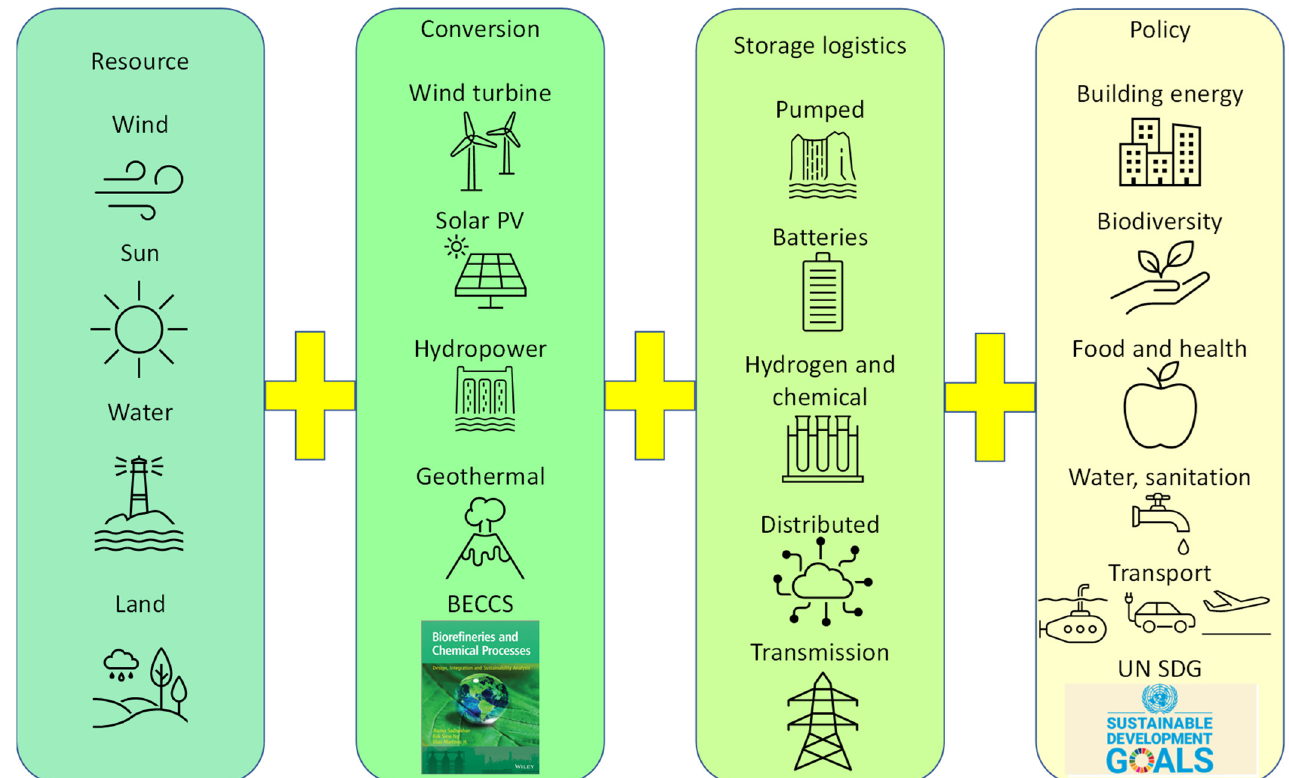
Figure 4. Global grand challenge: whole-system optimisation for sustainability.